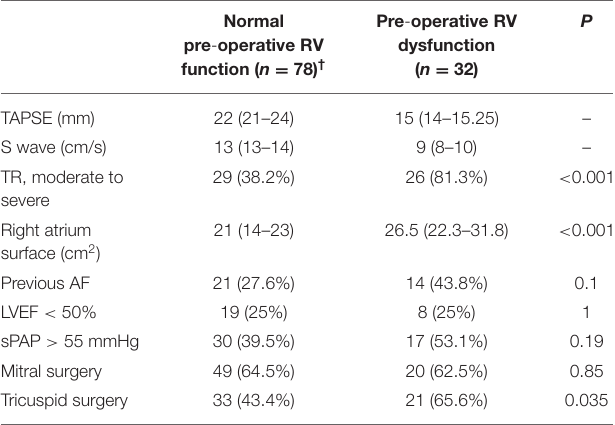
TABLE 4 | Comparison between patients with normal pre-operative RV function and patients with pre-operative RV dysfunction, in the subgroup of patients presenting post-operative RV dysfunction ( n =